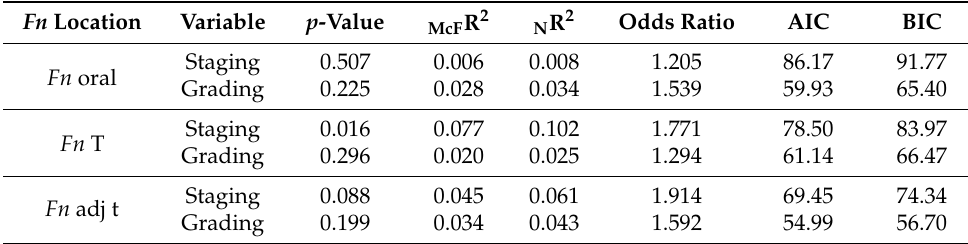
adj t: Adjacent non-neoplastic tissue and T: Tumor